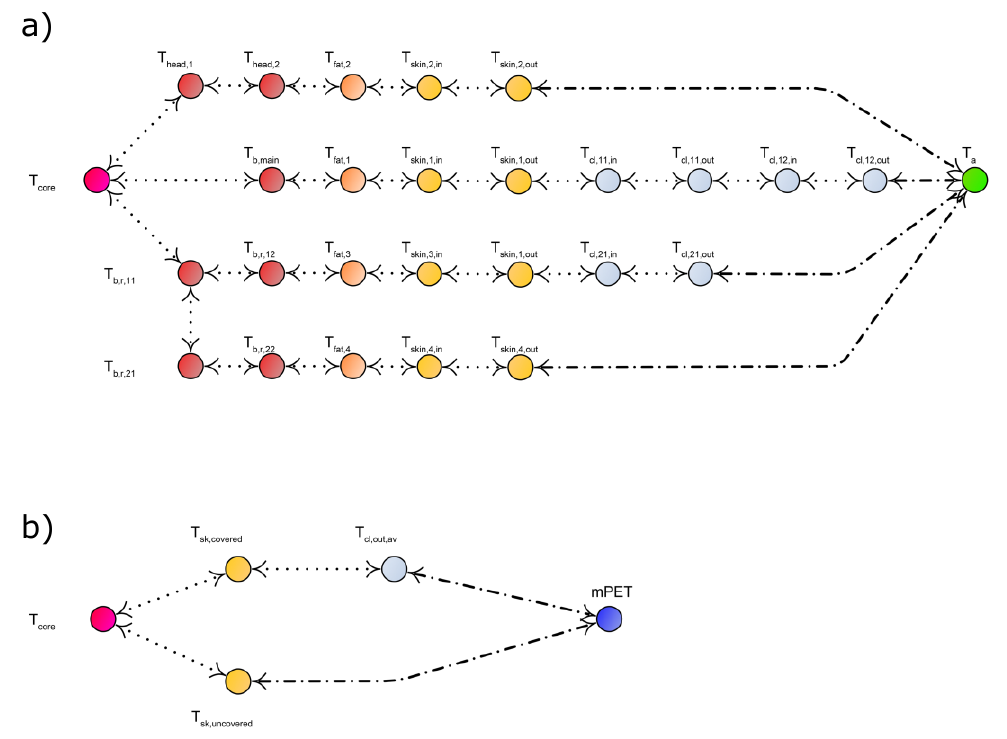
Figure 3. ( a ) The flow chart of sensible heat transfer of mPET-model with two-layer clothing and ( b ) calculation approach of mPET based on exchange